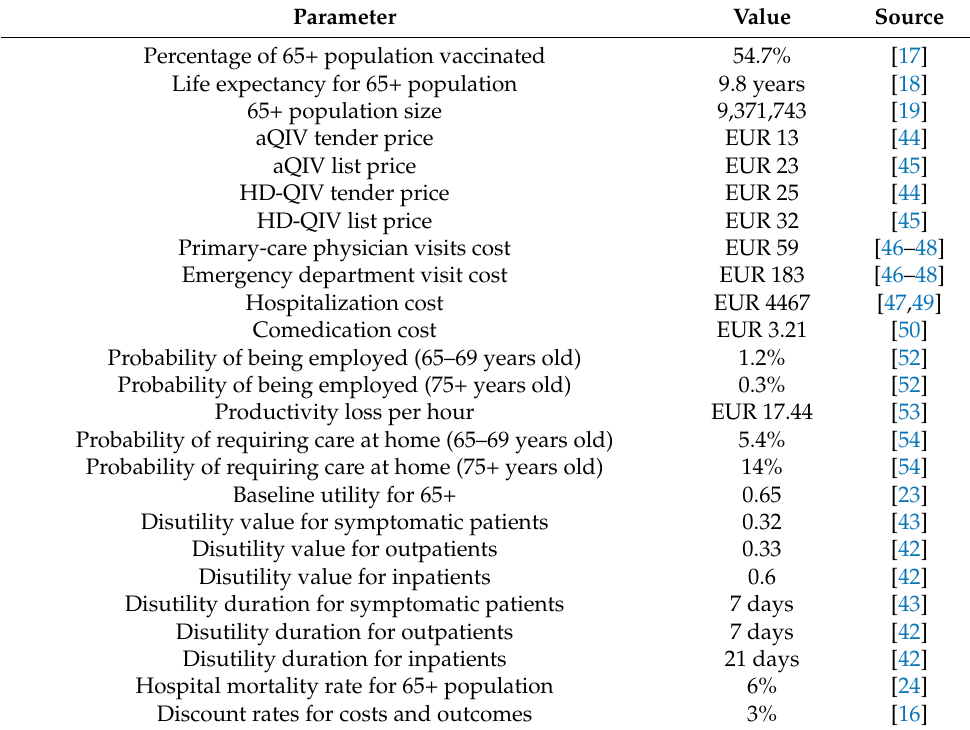
Table 2. Summary of parameters sourced for the model.